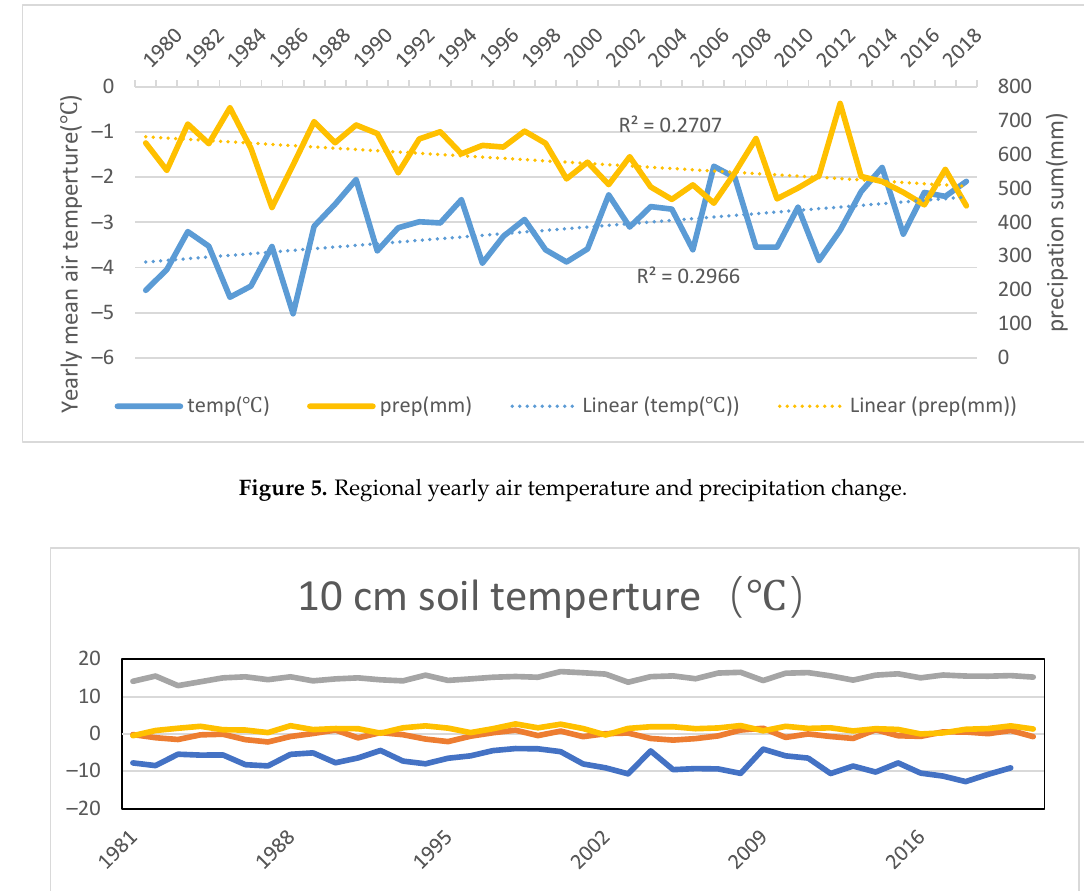
Figure 7. Seasonal wind direction.